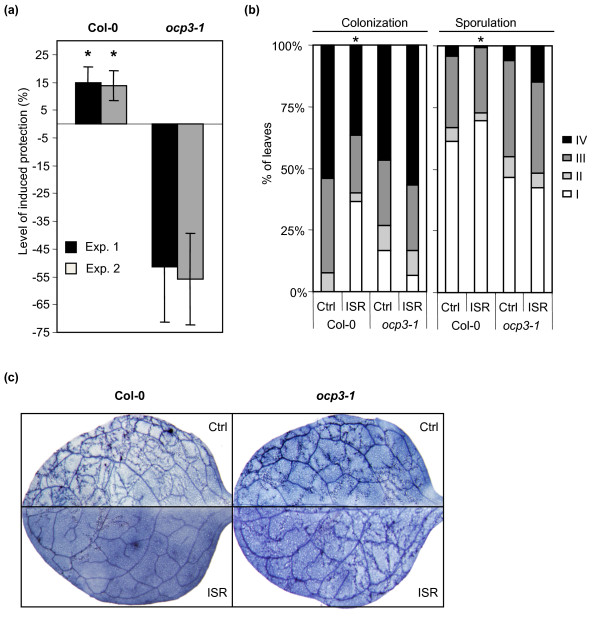
Mutant ocp3-1 plants are not able to mount ISR against P. syringae and H. arabidopsidis. (a) Quantification of P. fluorescens WCS417r-mediated ISR against Pst DC3000 in Arabidopsis Col-0 and ocp3-1 plants. The level of induced protection calculated on the basis of the reduction in disease symptoms relative to challenged, non-induced plants. Asterisks indicate statistically significant levels of protection compared to non-induced control plants (Students t-test: α = 0.05; n = 20 plants). Data presented are means from two independent experiments. Error bars represents standard errors. (b) Quantification of colonization and sporulation of H. arabidopsidis infected plants (From class I = no colonization/sporulation to class IV = high colonization/sporulation). Asterisks indicate statistically significant distributions of the disease severity classes compared to noninduced control treatments (Chi-square, P < 0.05; n = 200 leaves). The data presented are from a representative experiment that was repeated with similar results. (c) Lactophenol trypan-blue stained control- and P. fluorescens WCS417r-treated Col-0 and ocp3-1 plants 7 days after inoculation with H. arabidopsidis. Pst DC3000 inoculation experiments were repeated three times and twice for H. arabidopsidis always with a similar out come.